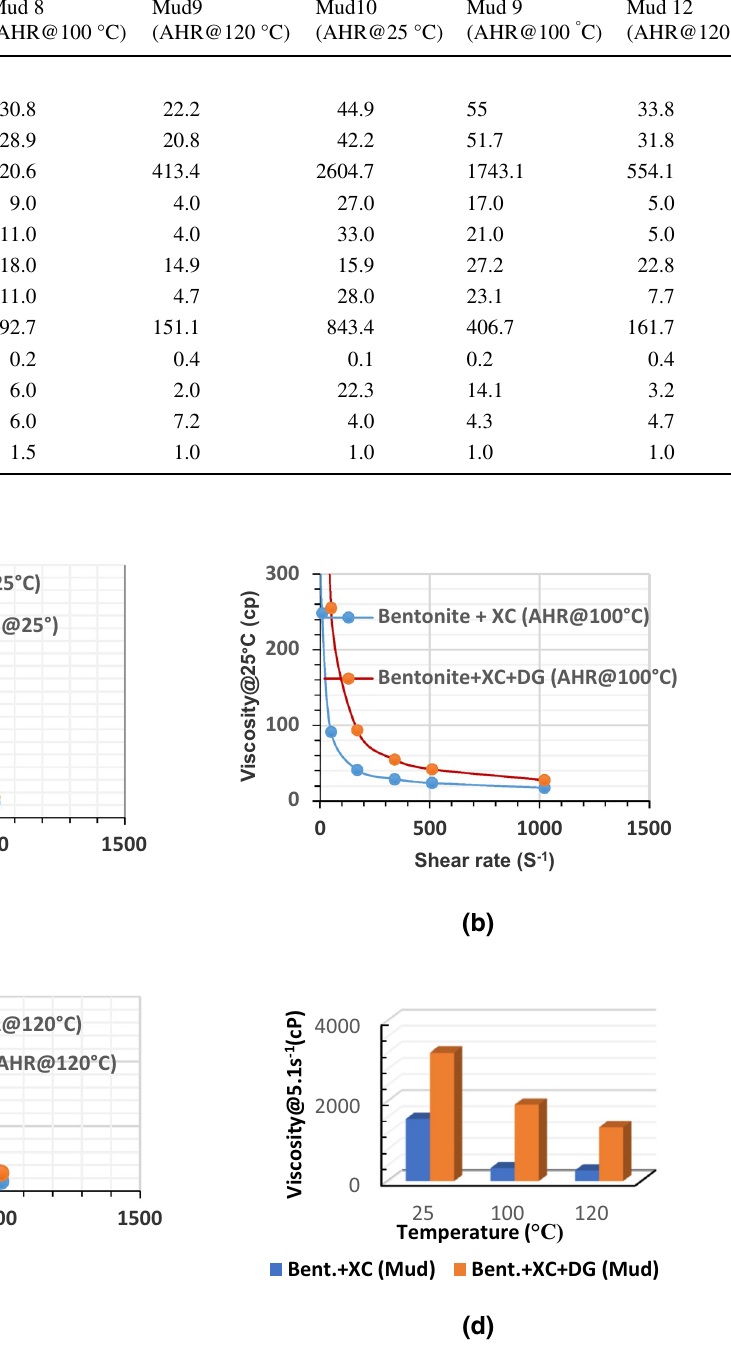
Fig. 4 Comparison of the properties of mud formulations: a viscosi- ties of mud formulations after static aging at 25 °C for 16 h; b vis- cosities of mud formulations after hot rolling at 100 °C for 16 h; c